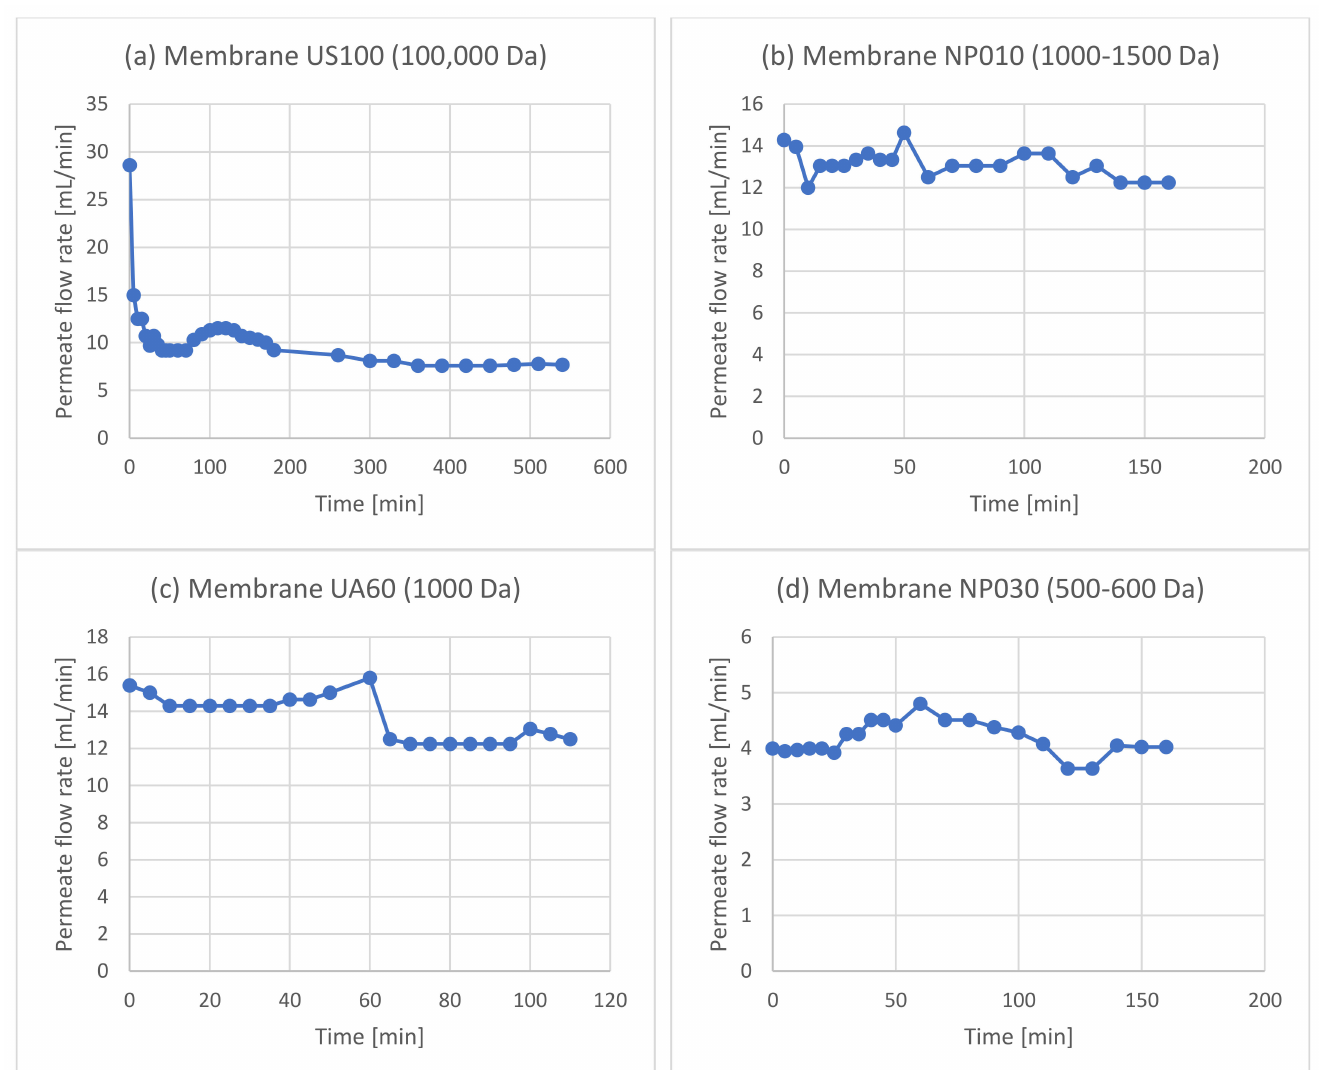
Figure A2. Permeate flow rates observed in the membrane treatment scheme after solid–liquid ex- traction in which only one ultrafiltration step (( a ) US100) was used and the permeate from the 100,000 Da membrane was split into three equal parts and was treated with three different nanofiltration membranes (( b ) NP010, ( c ) UA60, ( d )